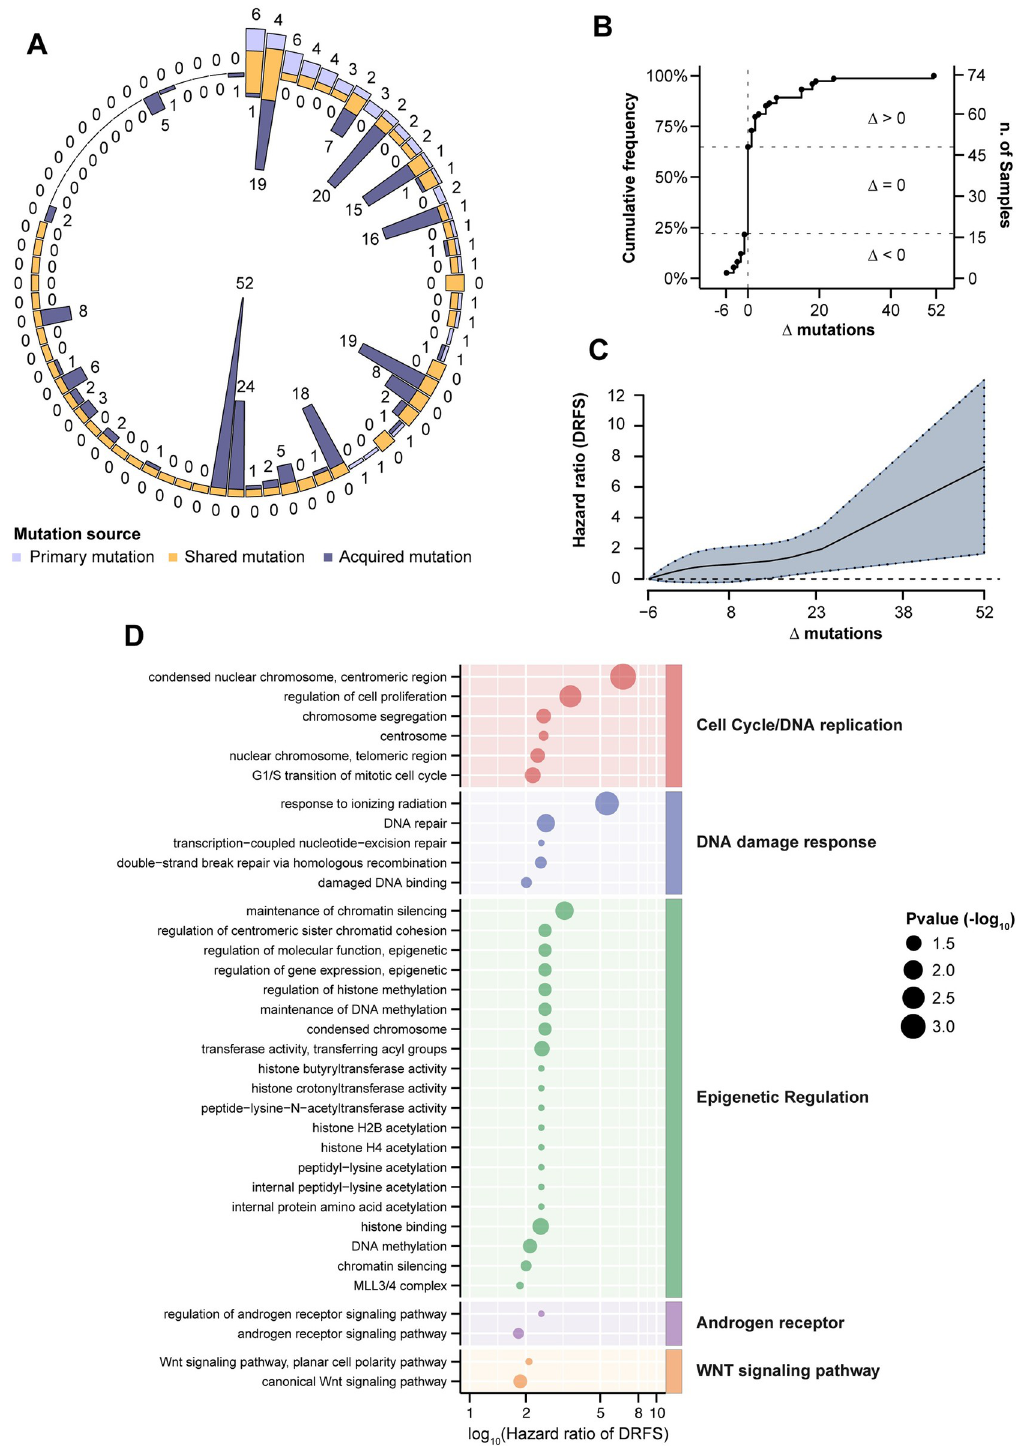
Fig 4. Genomic spectrum of acquired driver alterations. A) The circle graph represents for each case (n = 74) the proportion of driver mutations detected in primary and/or metastatic tumor samples. Outer numbers represent mutations of eBC, inner numbers represent mutations of mBC. B) Cumulative frequency of the difference ( Δ ) between number of mutations in metastatic vs . primary tumor samples ( Δ < 0, number of driver mutations in the primary tumor greater than in the corresponding metastatic sample; Δ = 0, equal number of driver mutations in primary vs . metastatic tumor; Δ > 0, number